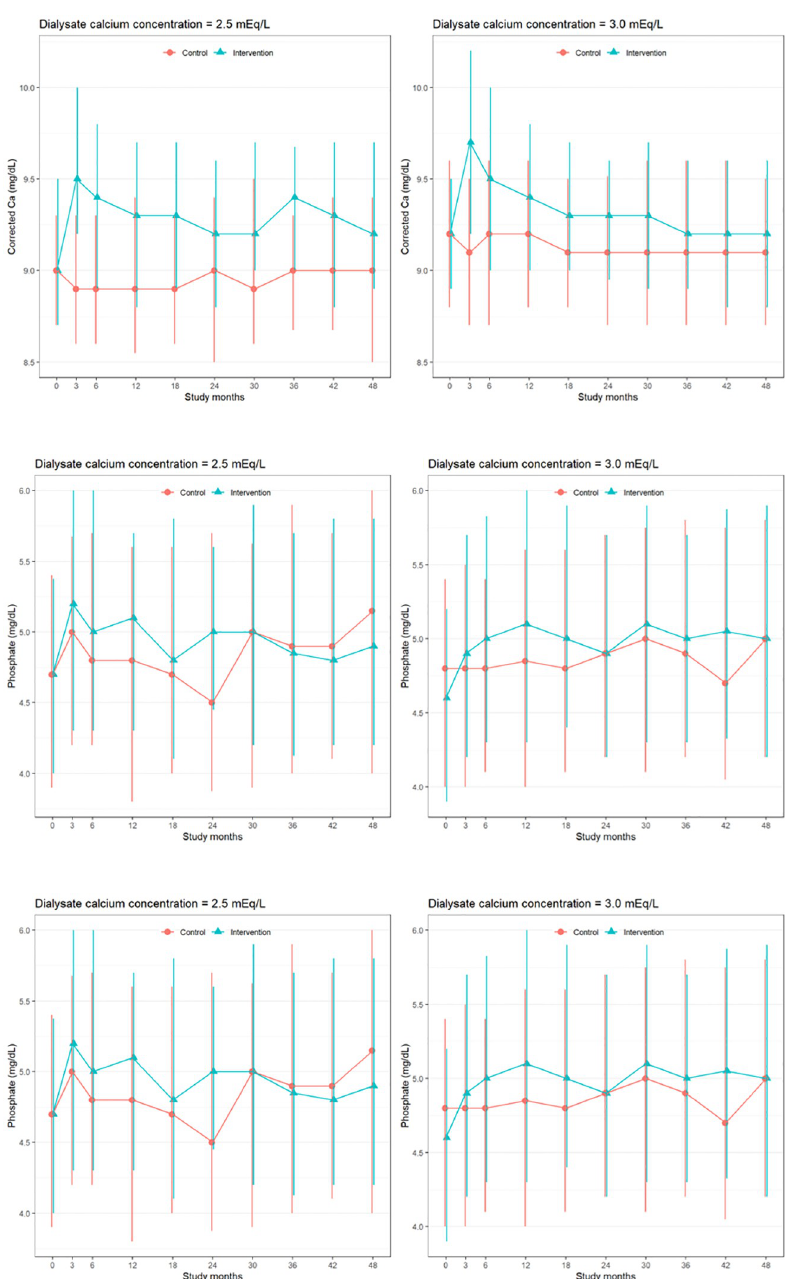
Fig 1. Serial changes in the median (25th, 75th percentile) of serum levels of corrected Ca, phosphate, and intact PTH in D-Ca 2.5 and 3.0